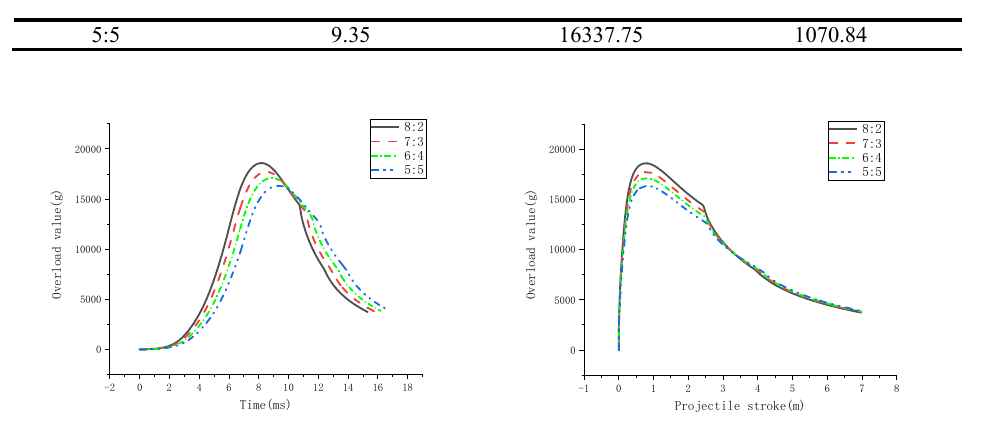
Fig. 5. a-l curves of different mixing ratios of main charge and coating charge.